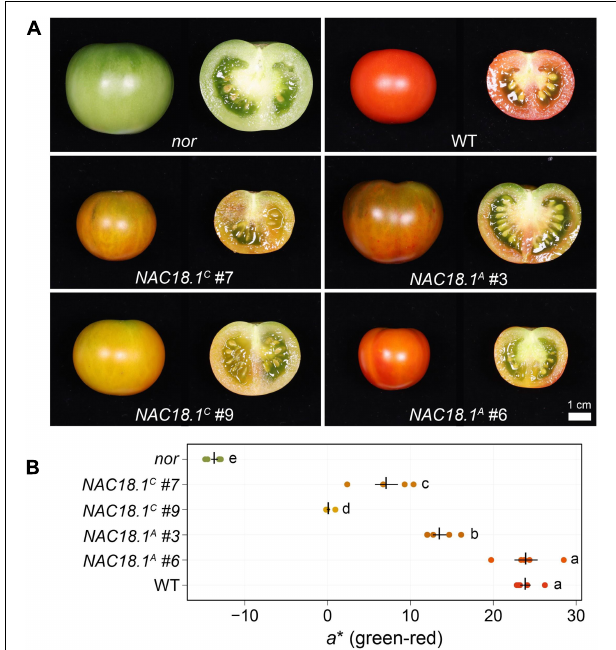
FIGURE 4 | Transgenic complementation of the tomato nor mutant using NAC18.1 transgene restores ripening. (A) Mature fruit of the tomato nor mutant and four independent T1 transgenic lines constitutively expressing either of two alleles of the NAC18.1 transgene, NAC18.1 C and NAC18.1 A and isogenic WT control (cv. Ailsa Craig). (B) Quantitative colorimetry of the fruit surface of nor, the transgenic fruit and WT fruit. The a * component (green-red axis) is shown, with the mean ± SE superimposed in black over the raw values ( N = 5) in a color approximating the external color of the fruit. Genotypes not sharing a letter (a-e) are statistically distinct by one-way ANOVA and Tukey’s HSD test ( p <